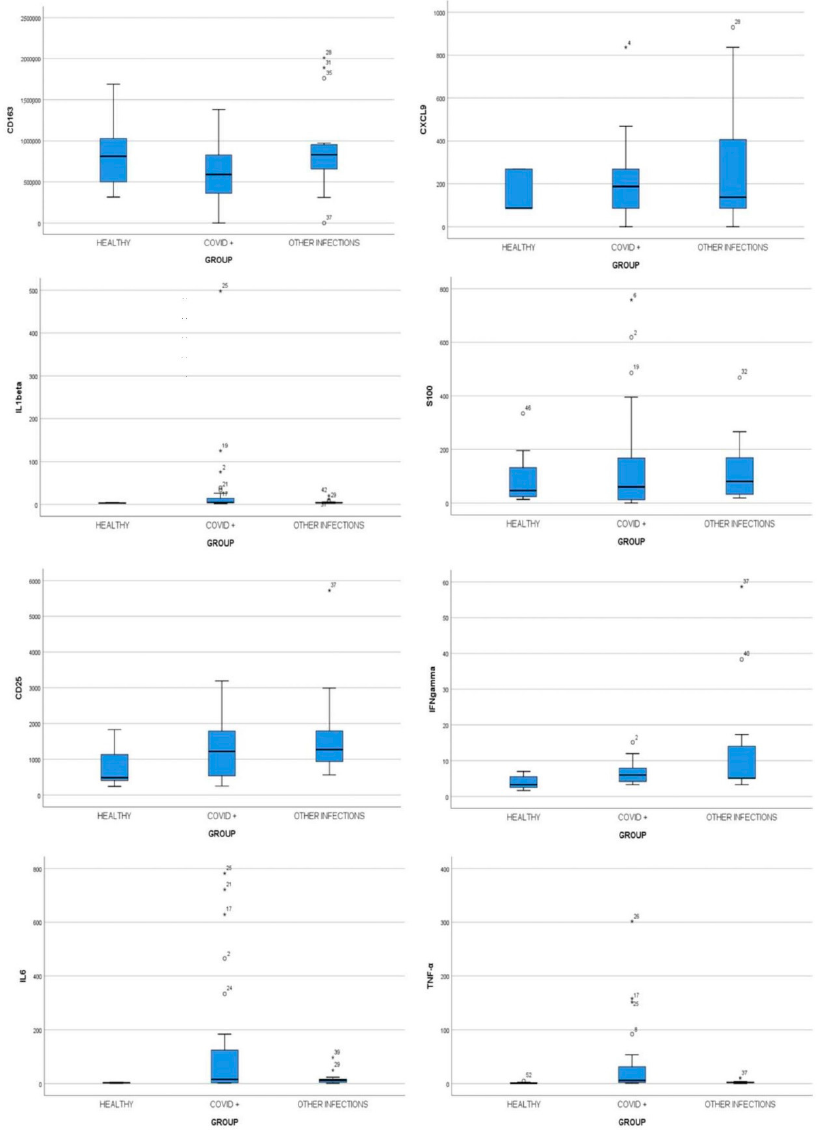
Figure 1. Cytokines evaluation in children affected by COVID-19 (Group 1), with other infectious diseases (Group 2), and children without infections (Group 3). Plasmatic levels of CD163, CXCL9, IL1 β , S100b, CD25, IFN- γ , TNF- α , and IL6 were measured by Bead Array flow cytometry assay on a single serum sample at admission to the ED using the Human Magnetic Luminex Screening Assay. ANOVA and Kruskal–Wallis comparison tests were used to compare values between COVID-19 children, children with other infections, and healthy control subjects.